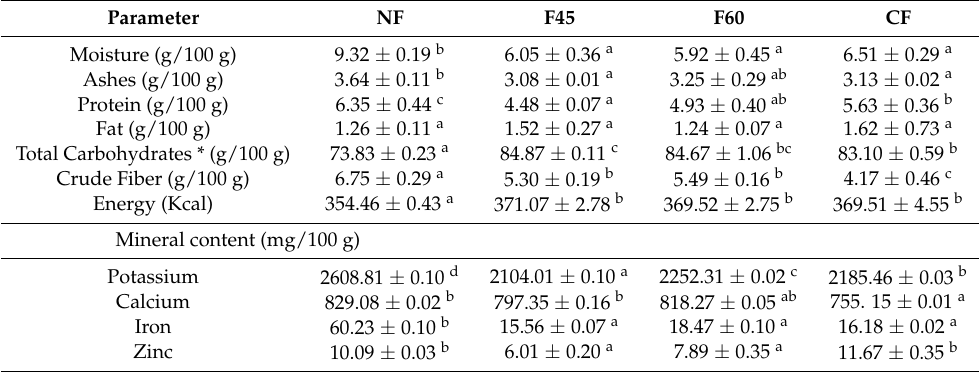
Table 3. Nutrimental composition and mineral content of Maya nut